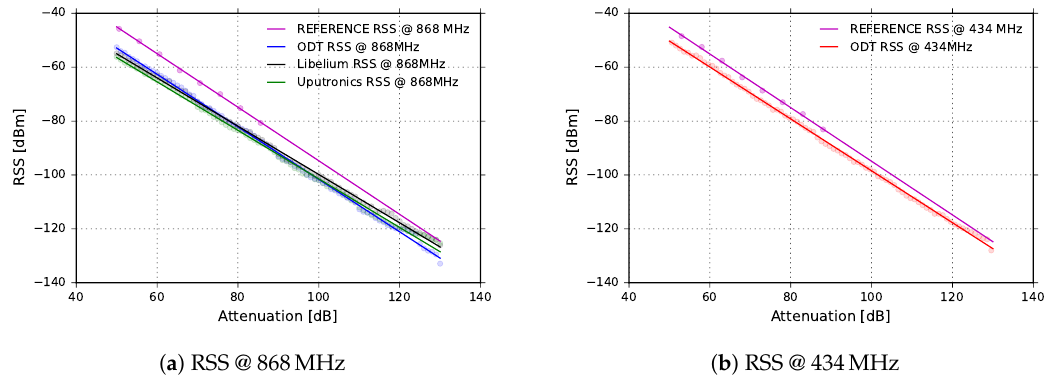
Figure 7. Received signal strength vs. channel attenuation for reference RSS and ( a ) ODT(868MHz), Libelium (868MHz) and Uputronics (868MHz), ( b ) ODT(434MHz).